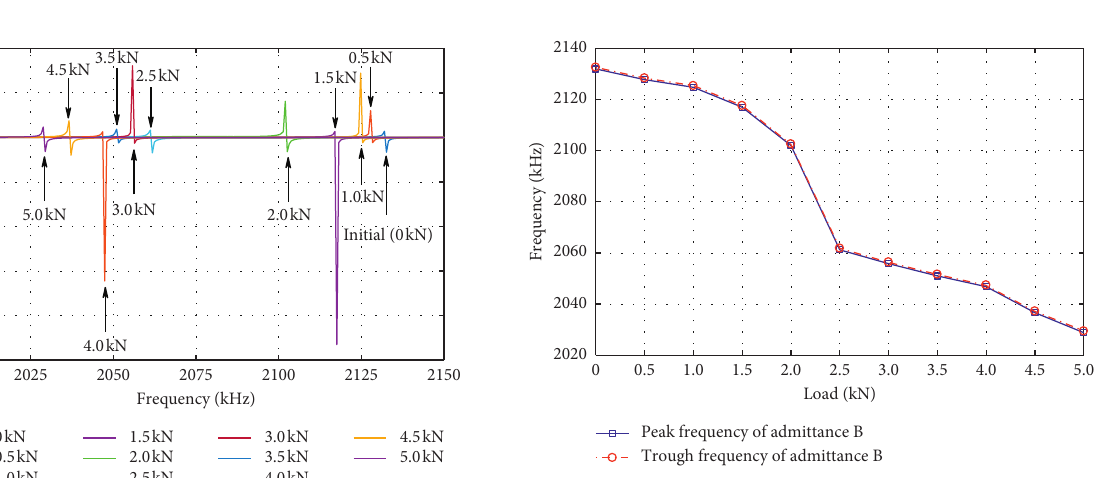
Figure 5: Scanned results for the additional experiment.